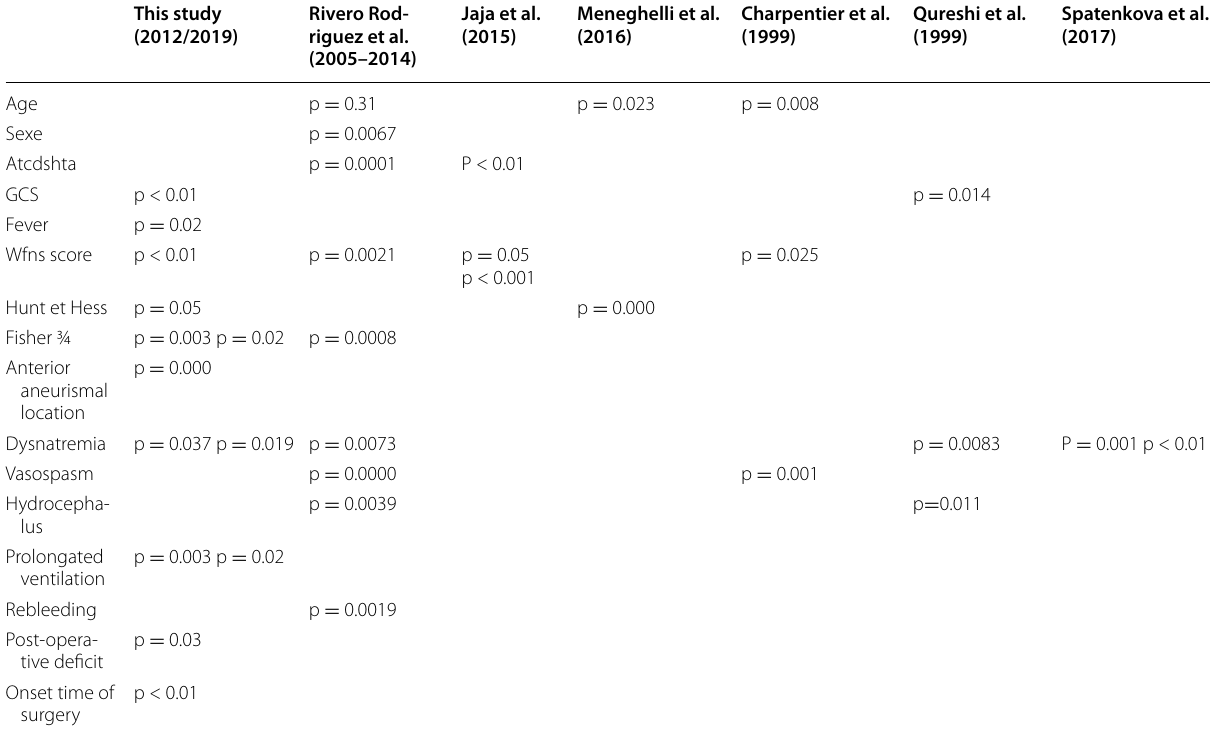
Table 1 Comparison of our results with medical